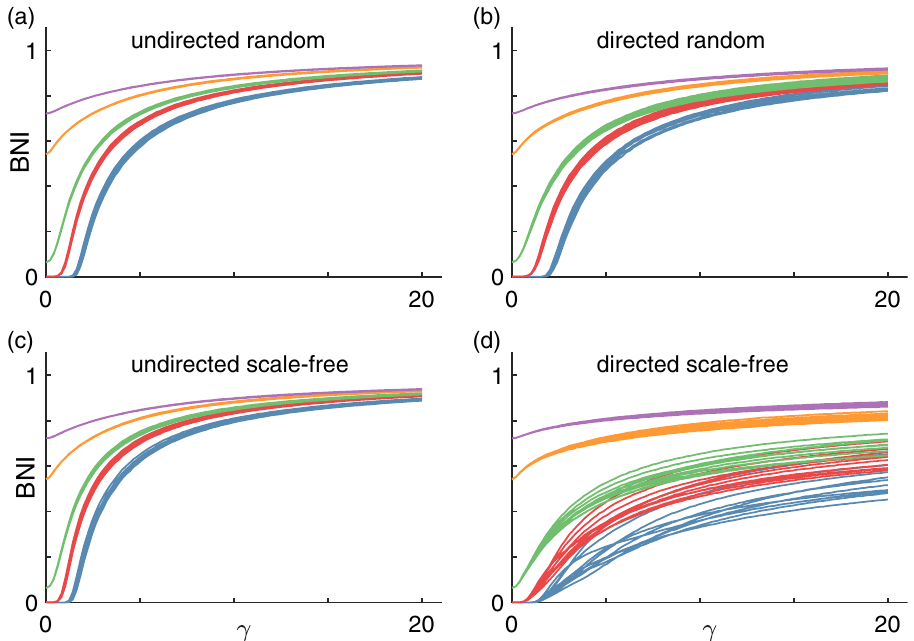
Figure 4. BNI as a function of additive coupling strength γ . Each panel shows BNI curves for different network topologies: ( a ) undirected random networks, ( b ) directed random networks, ( c ) undirected scale-free networks, and ( d ) directed scale-free networks. Each color corresponds to a different level of noise α : blue is α = 0.001 , red is α = 0.005 , green is α = 0.01 , orange is α = 0.03 , and purple is α = 0.05 . Finally, each curve corresponds to